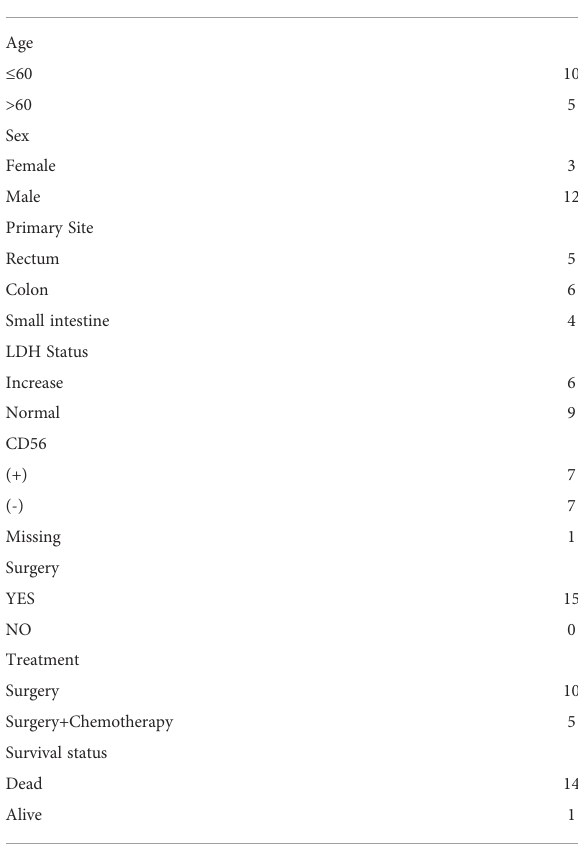
TABLE 1 Clinical features of GI-NKTCL cases (N =